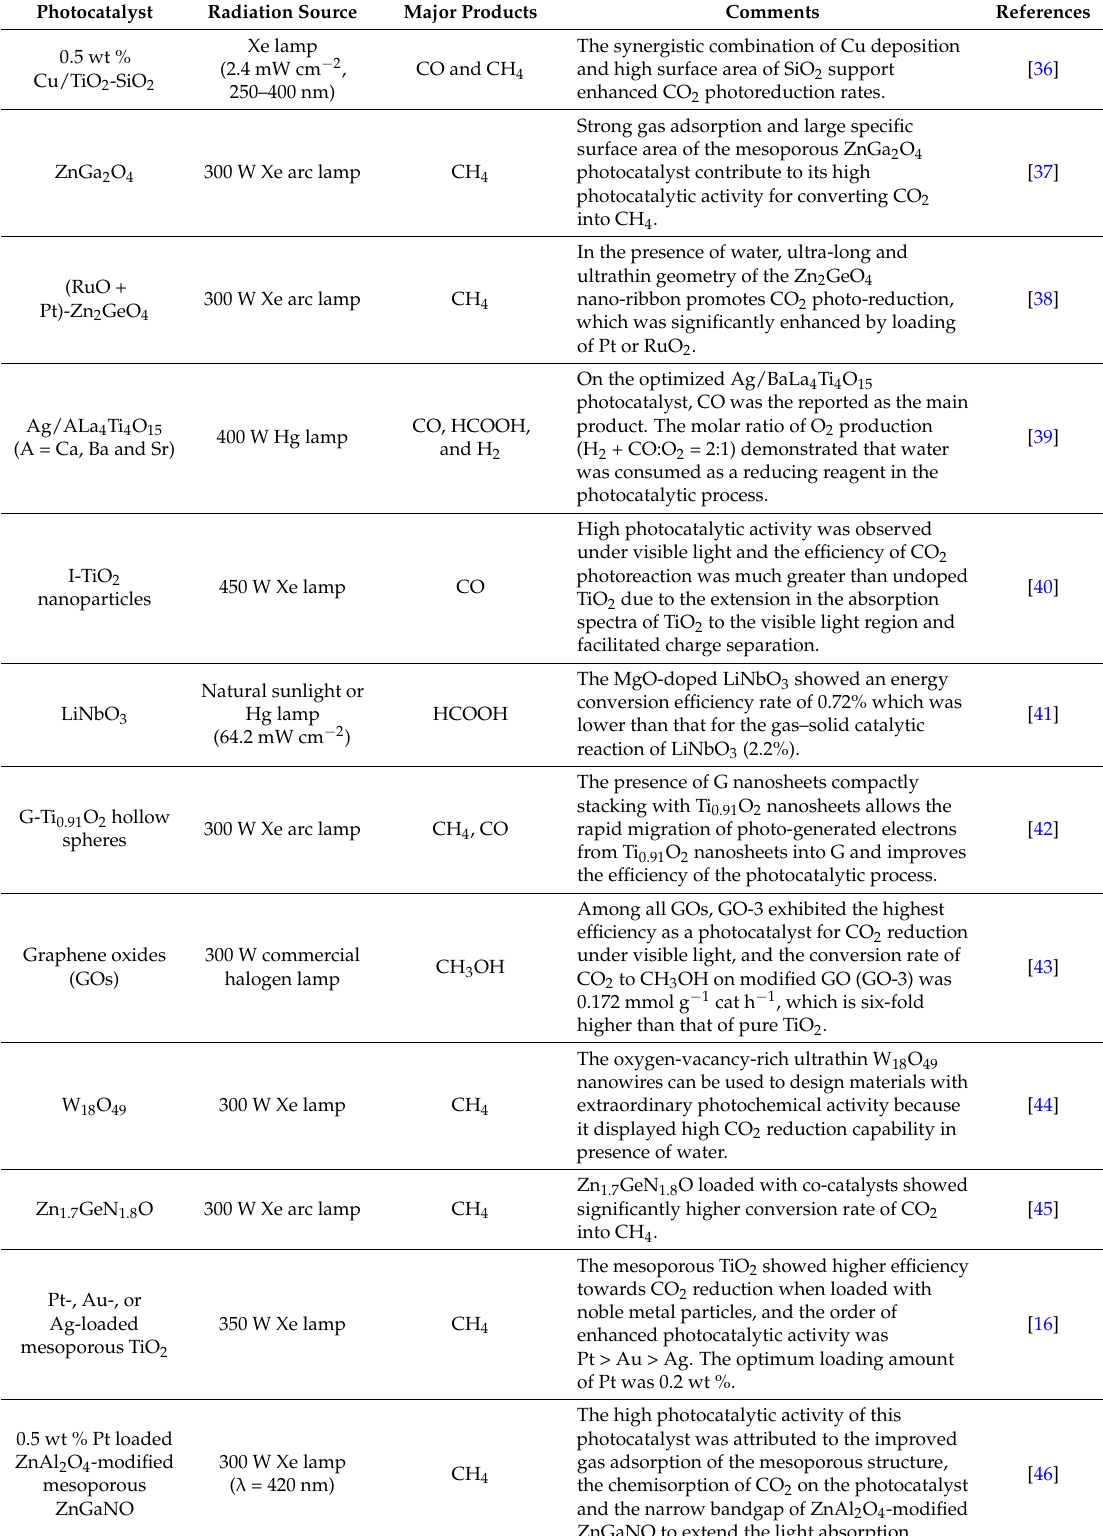
Table 1. Advances in photocatalytic systems for CO 2 reduction with water since the year